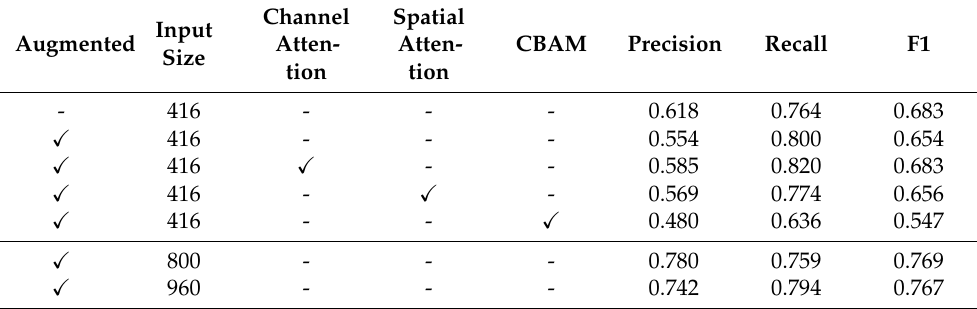
Table 4. Performance of the YOLOv3 with different improvement techniques on the PSP dataset.